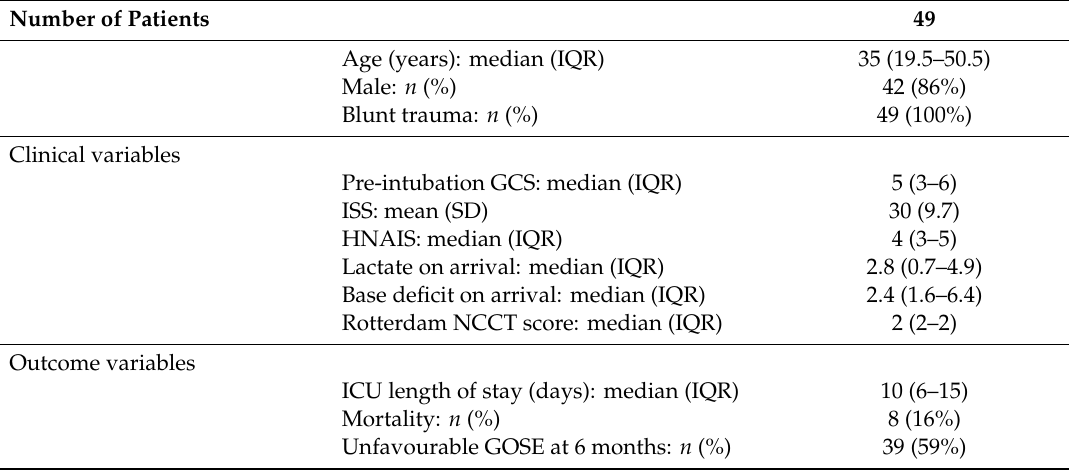
Table 1. Demographic, clinical and outcome details of the study population.